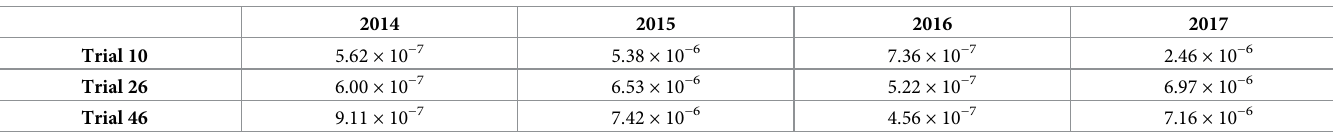
Table 1. RMSEs of the simulation over the 2014–2017 period a